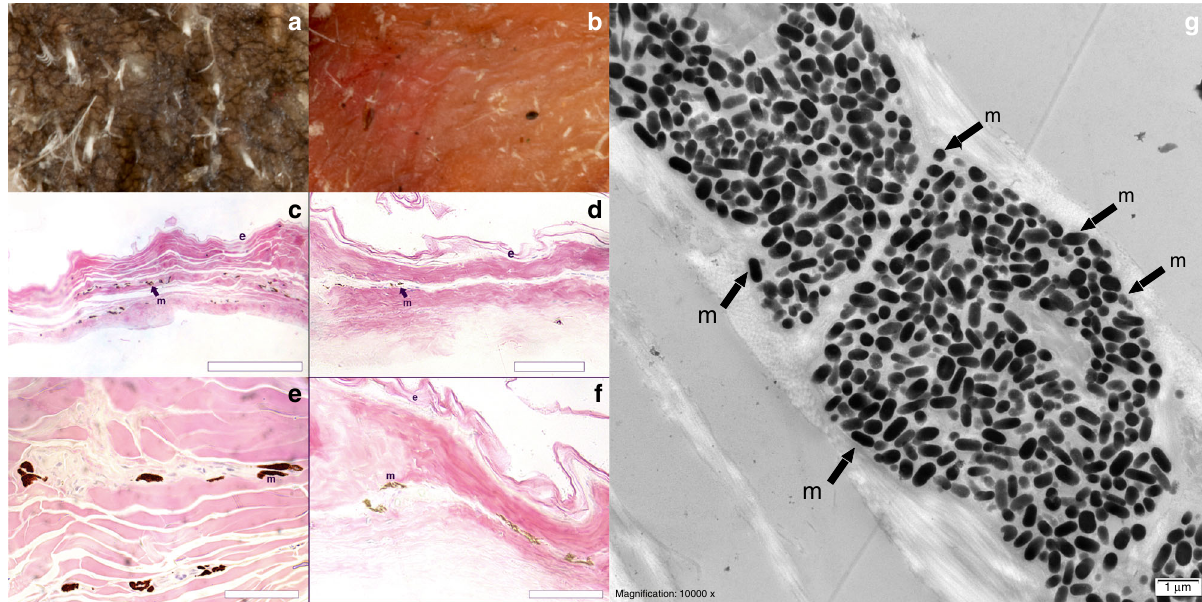
Fig. 1 Differences in skin colour of (a) Morus bassanus (black) and (b) Garrulus glandarius (red) are due to differences in melanin concentration as seen under light microscopy for (c, e) M. bassanus and (d, f) for G. glandarius . Scale bars represent 50 μ m ( c , d ), 30 µ m ( e , f ) and 1 µ m ( g ). e stands for epidermis, m for melanin. While melanin is present in both tissues, concentrations appear much higher in black skin. g Detail of a melanophore containing individual melanosomes (few examples indicated by an m) from M. bassanus (scale bar 1 µ